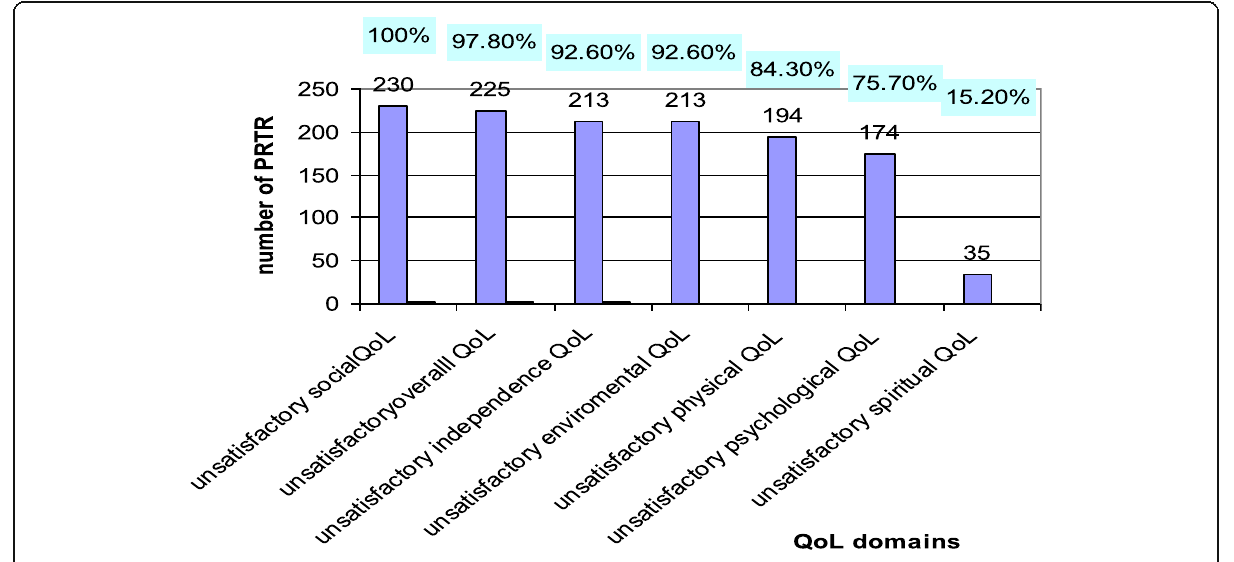
Fig. 1 Quality of life in different